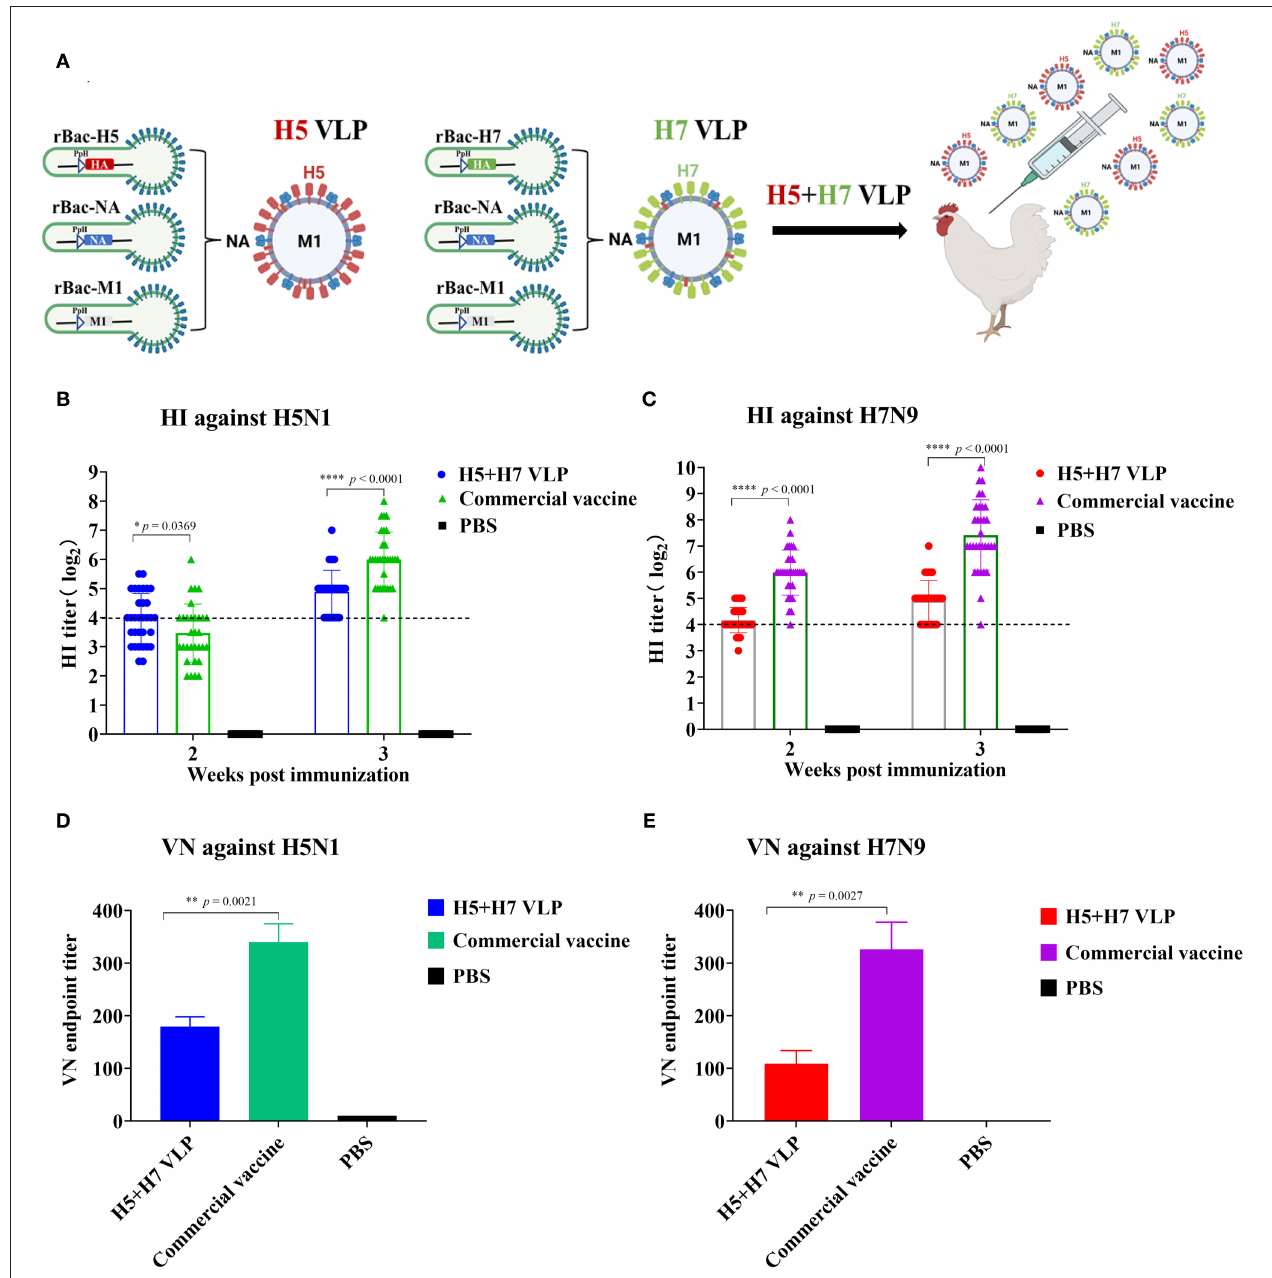
FIGURE 2 | The bivalent H5 + H7 VLP vaccine induces efficient HI and VN antibodies. (A) To assess the immunogenicity of the vaccine candidate, chickens were intramuscularly (i.m.) immunized with 15 µ g of the bivalent H5 + H7 VLP or 0.3mL of the commercial trivalent (H5: Re-11; H5: Re-12; H7: Re-3) vaccine. (B) HI titers at Week 2 and 3 p.v. against H5N1 TT3 virus. (C) HI titers at Week 2 and 3 p.v. against H7N9 GD15 virus. (D) VN antibody against 100 TCID 50 of H5N1 TT3 virus. (E) VN antibody against 100 TCID 50 of H7N9 GD15 virus. The detection limit was below 4 log 2 for the HI assay and below 10 for the VN